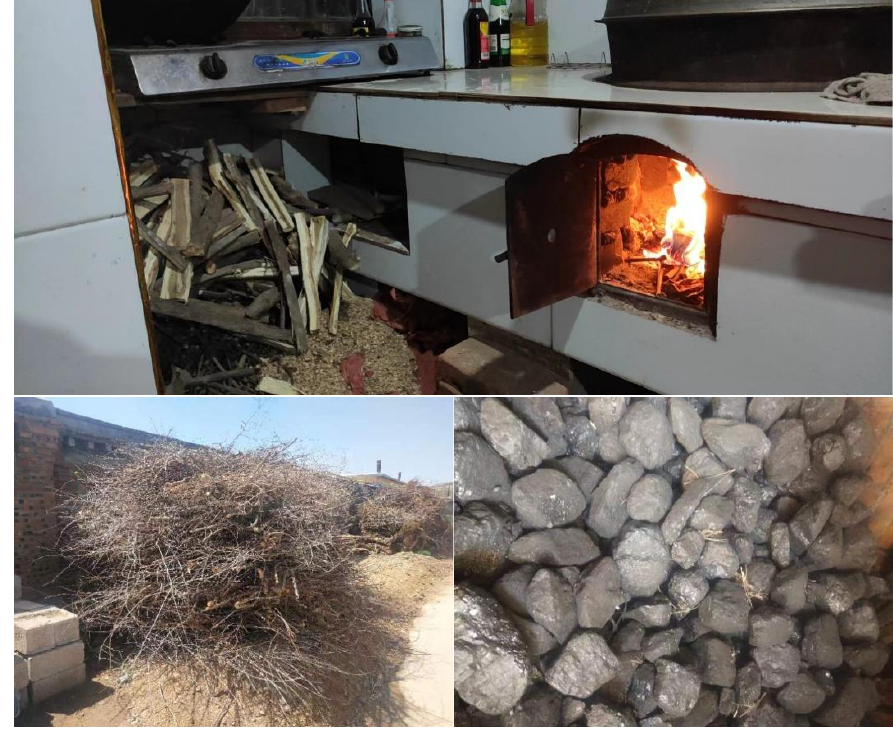
Figure 1. Map of sample distribution in the study areas. Note: This is a schematic map and does not indicate the definite boundaries.